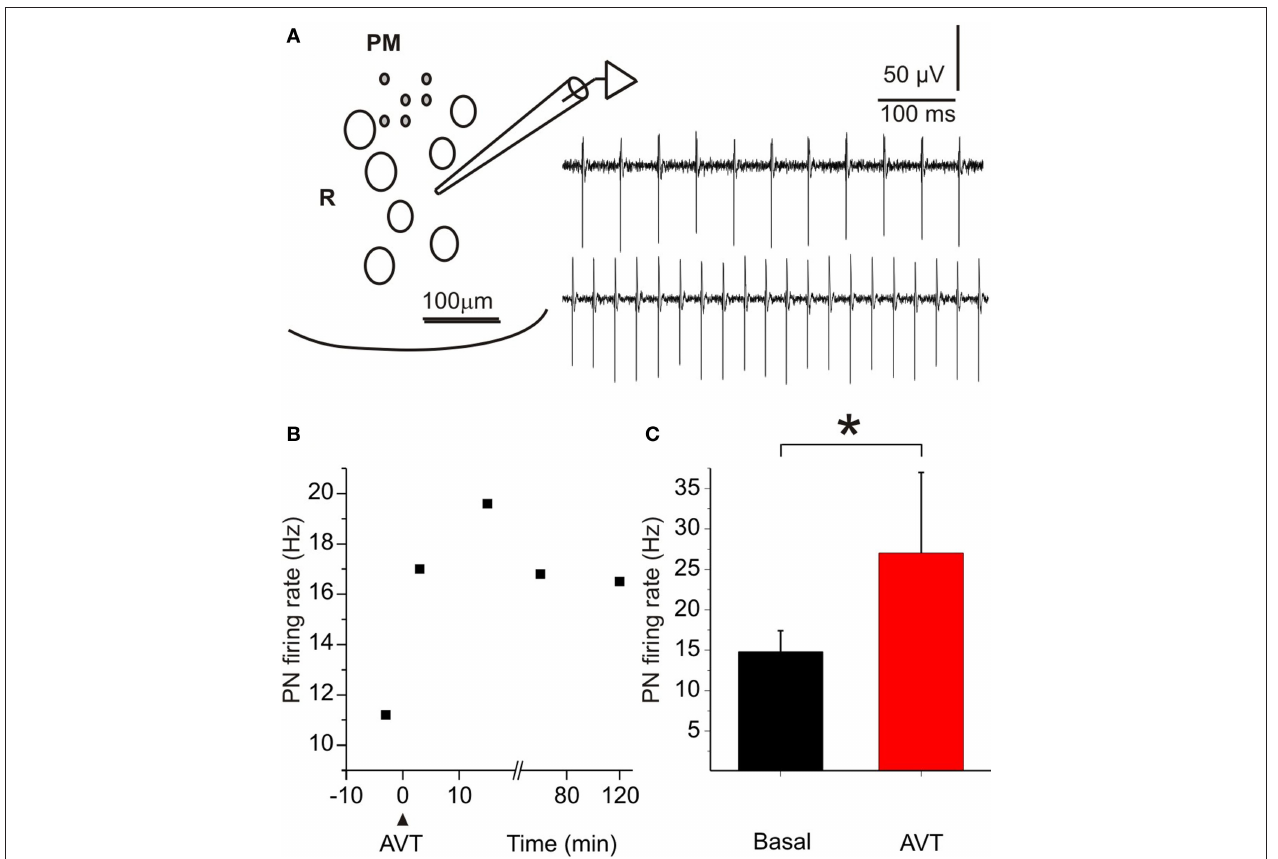
FIguRE 6 | Effects of AVT upon the firing rate of the pacemaker nucleus of Brachyhypopomus gauderio during the non-breeding season . (A) Cartoon of a transverse section of the medulla at the level of the PN (ventral region) to show the position of the recording pipette. PM: pacemaker neurons; R: relay neurons. Field potential recordings in basal conditions (upper trace) and during